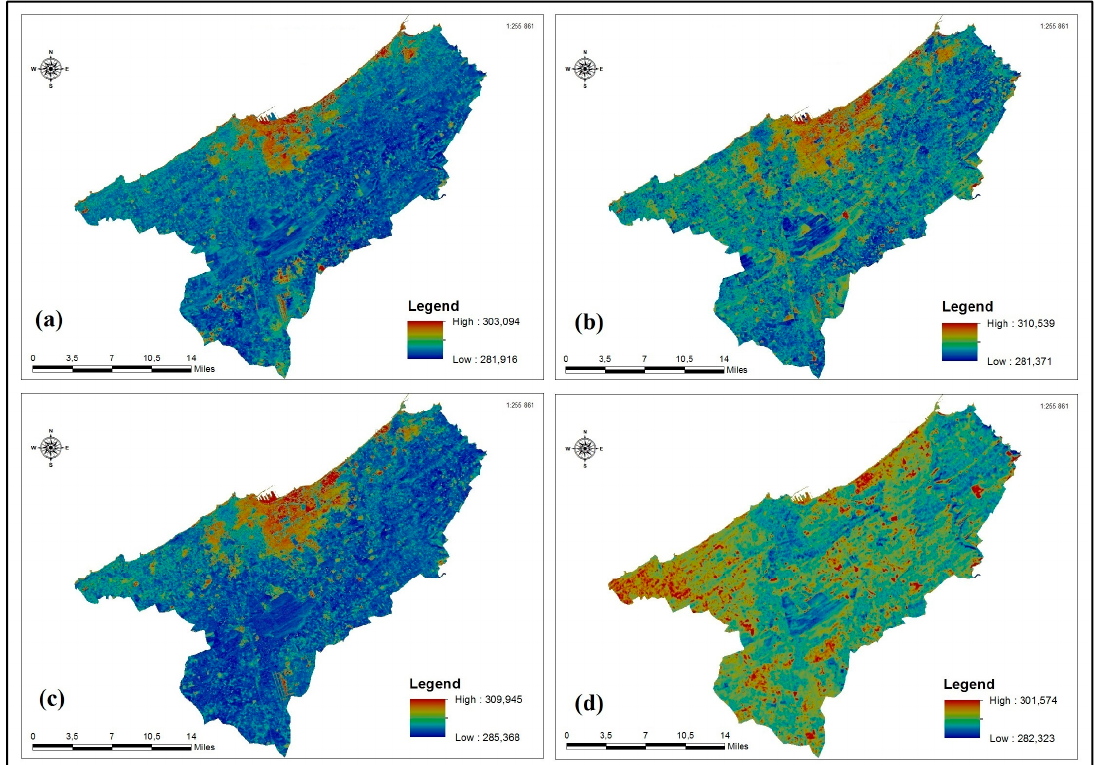
Figure 5 . Spatial distribution of LST during winter from 1987 to 2015: ( a ) LST retrieved from TM (7 February 1987); ( b ) LST retrieved from ETM+ (8 February 2002); ( c ) LST retrieved from TM (8 January 2011); and ( d ) LST retrieved from OLI/TIRS (3 January 2015).